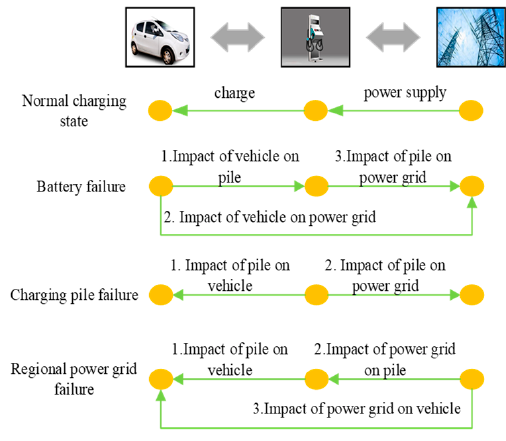
Figure 1. Vehicle–Pile–Grid Integrated Safety